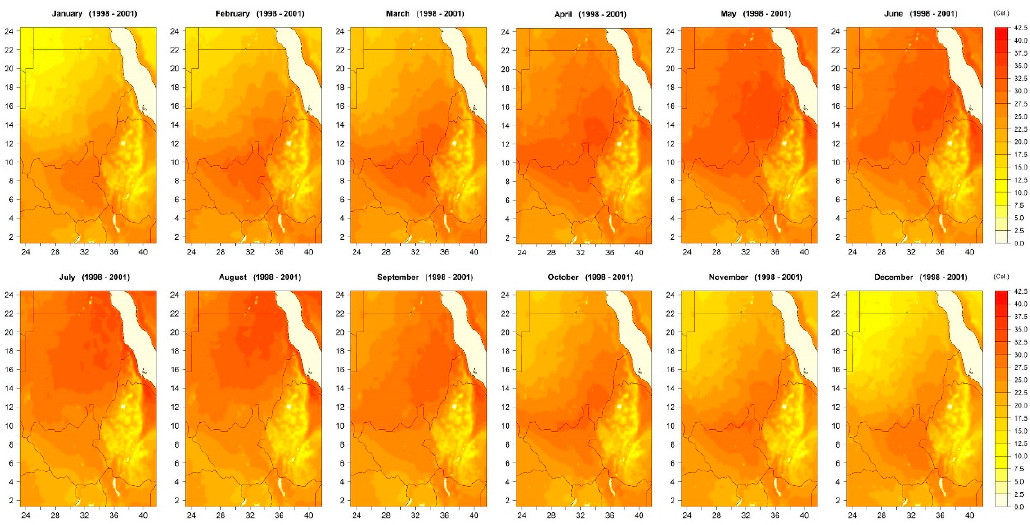
Figure 5. Simulated average surface air temperature based on the WRF model for each month over the ENB during the period 1998–2001, Longitude on the horizontal axis and latitude on the vertical axis.